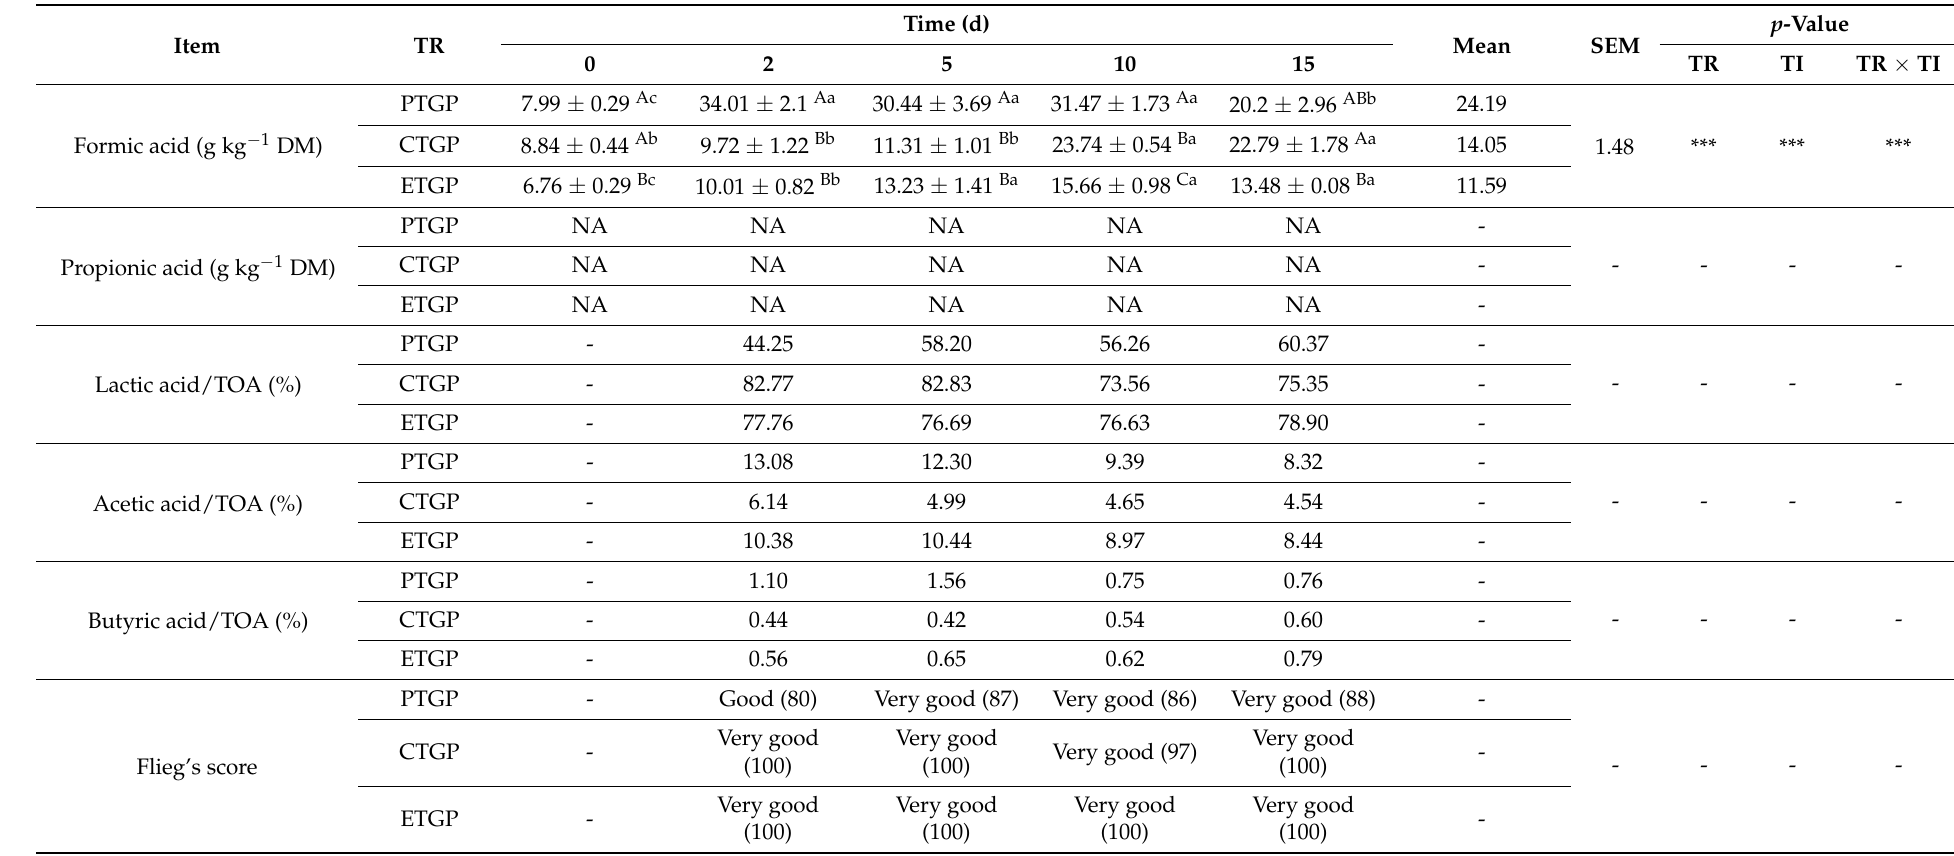
Table 5. Fermented quality of fermented feed evaluated by Flieg’s score based on the concentration of organic